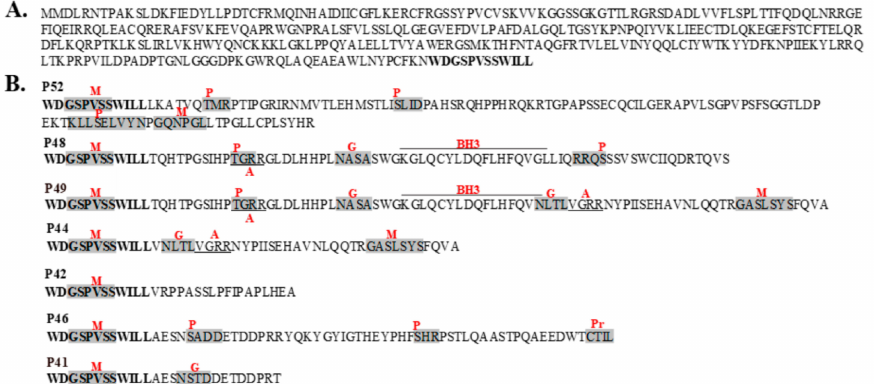
Figure 1. The unique C-terminal amino acid sequences of seven hOAS1 isoform proteins. ( A ) The common N-terminal sequence shared by all of the hOAS1 isoforms. The bolded C terminal sequence is repeated in the bottom panel. ( B ) The unique C-terminal sequences of the isoforms. Predicted post-translational modification sites or domains are indicated by red letters. M, N-myristoylation site; P, various predicted phosphorylation sites; G, N-linked glycosylation site; A, amidation site; Pr, prenylation site; BH3, BH3 domain. Post translational modification sites were predicted using PROSITE (https: //